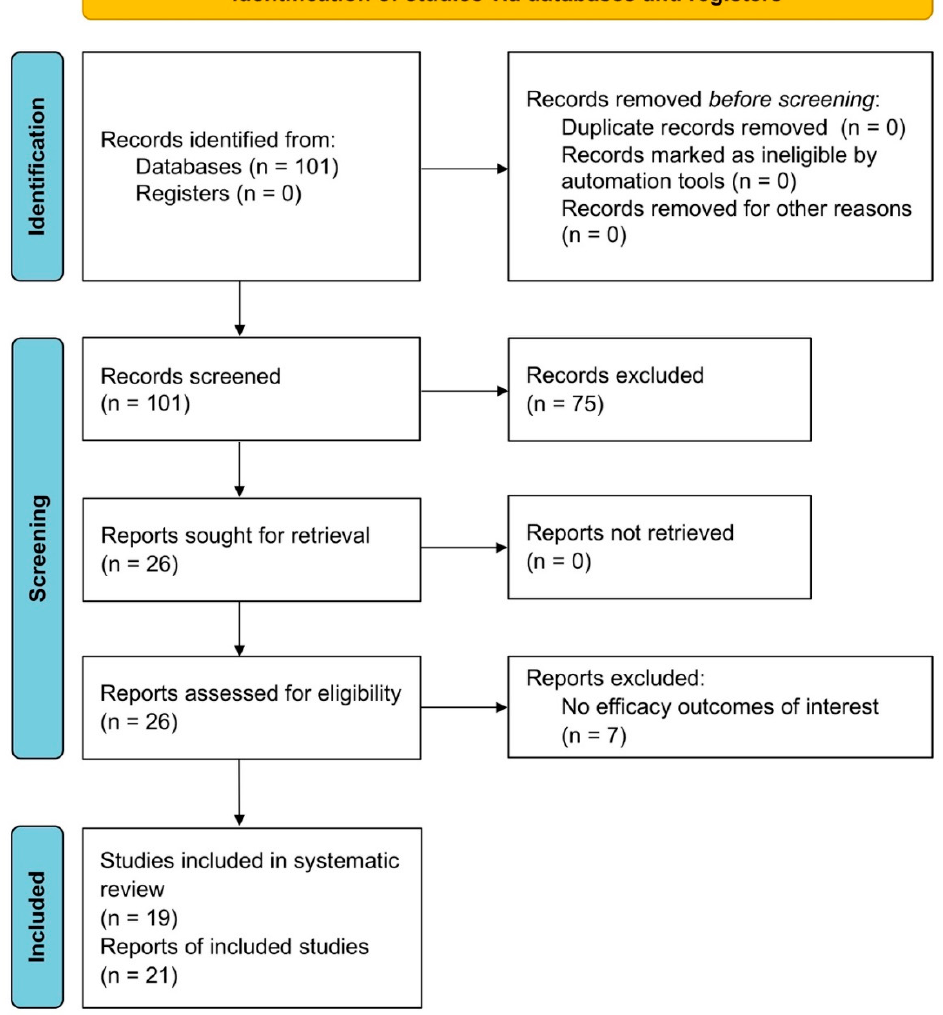
Figure 1. PRISMA 2020 flow diagram for the identification of the RCTs included in the qualitative and quantitative syntheses. PRISMA: Preferred Reporting Items for Systematic Reviews and Meta- Analyses; RCT: randomised controlled trial.